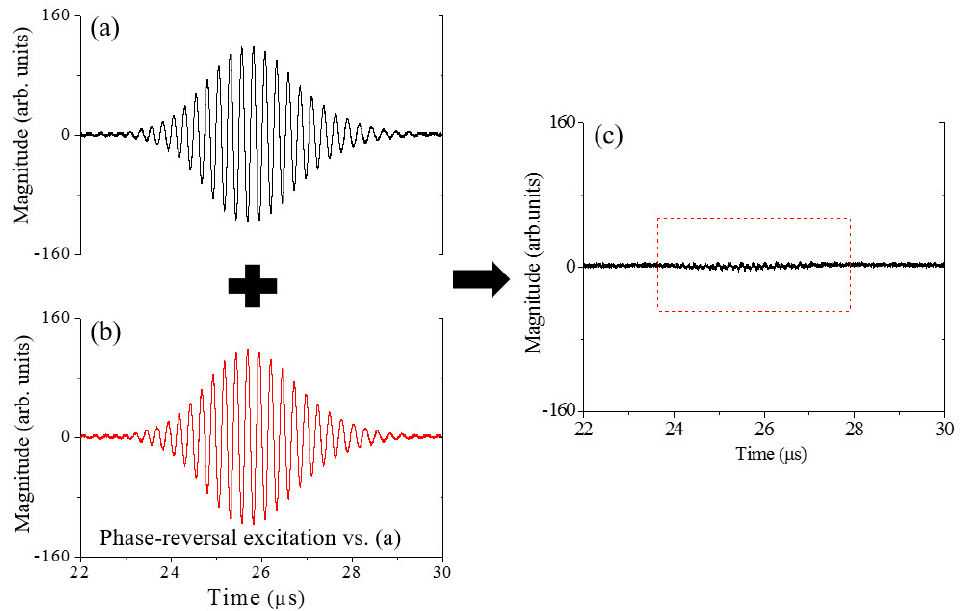
Figure 8. ( a , b ) the time-domain signals detected by Rx at z = 30 mm; ( c ) the superposition signal of the signals ( a , b ).